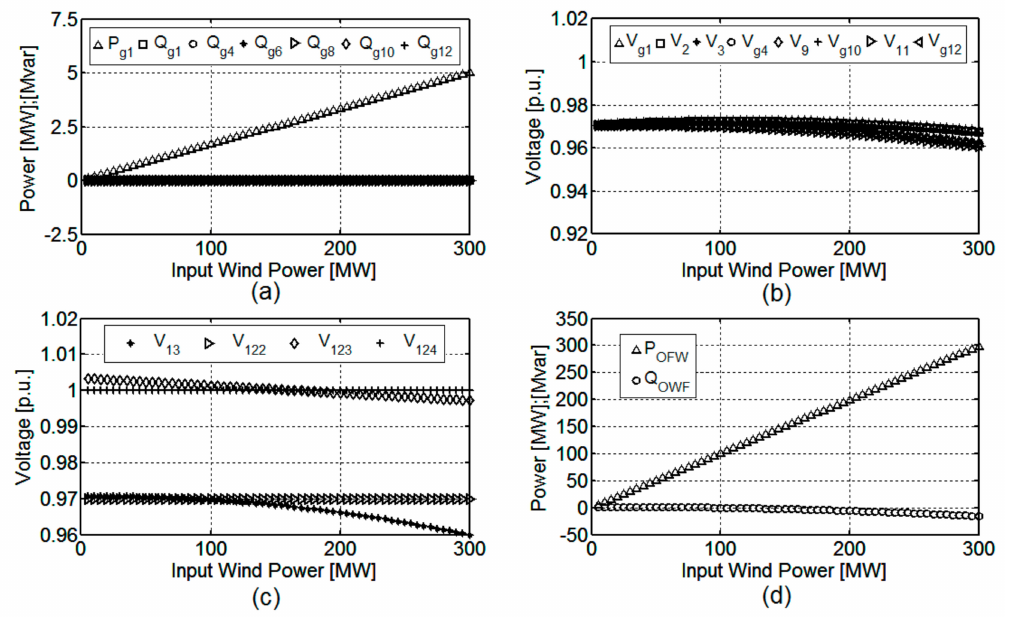
Figure 8. Steady-state curves without optimization (DFIG pf = 1.0): ( a ) Active and reactive power in each DFIG of the first row of the OWF; ( b ) AC voltage modules of the first row of the OWF; ( c ) AC voltage module in the VSC-HVdc model; ( d ) active and reactive power at the bus collection of the